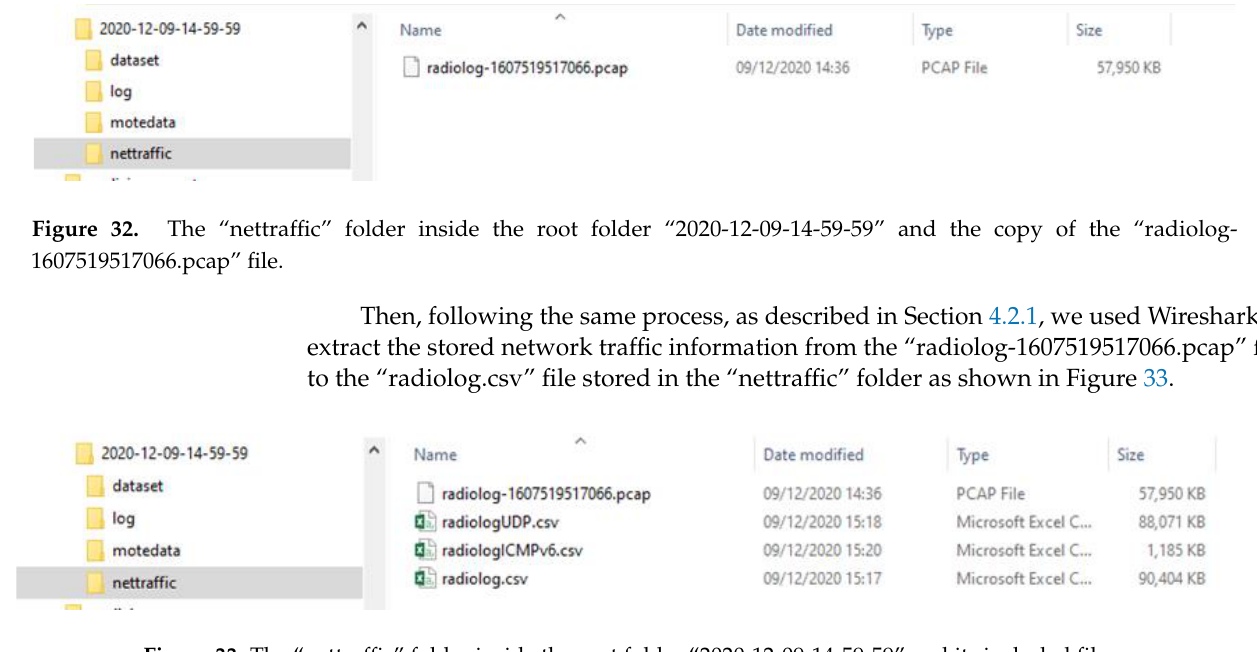
Figure 33. The “nettraffic” folder inside the root folder “2020 -12-09-14-59- 59” and its included files .